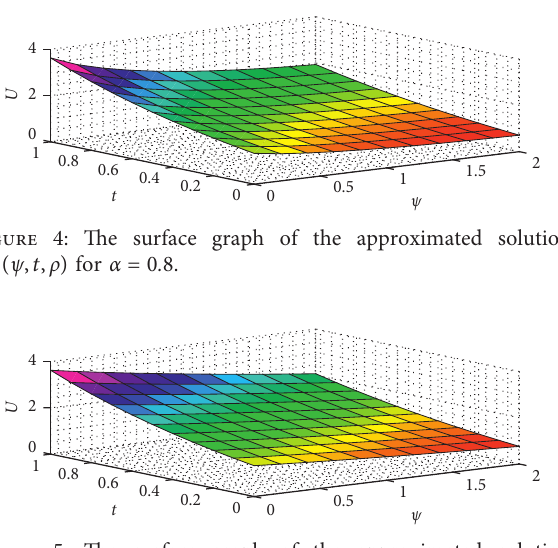
Figure 5: The surface graph of the approximated solution ( ψ ,t, ρ ) for α � 0 . 9. U 3